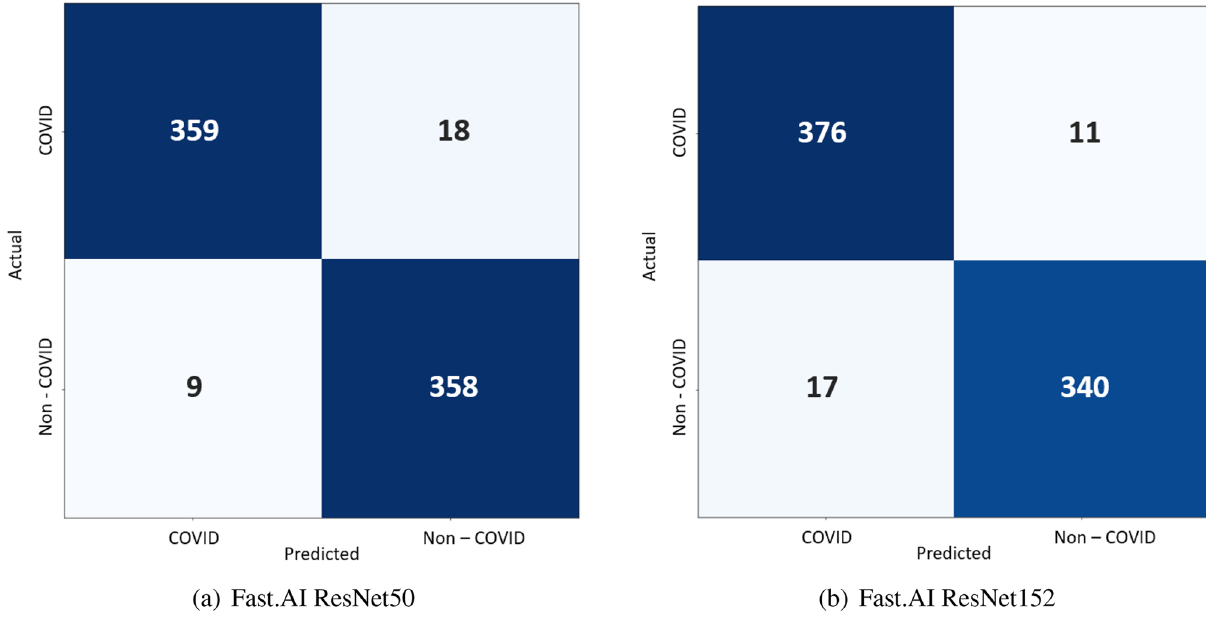
Figure 10. Confusion matrix for Fast.AI ResNet on CT-scan